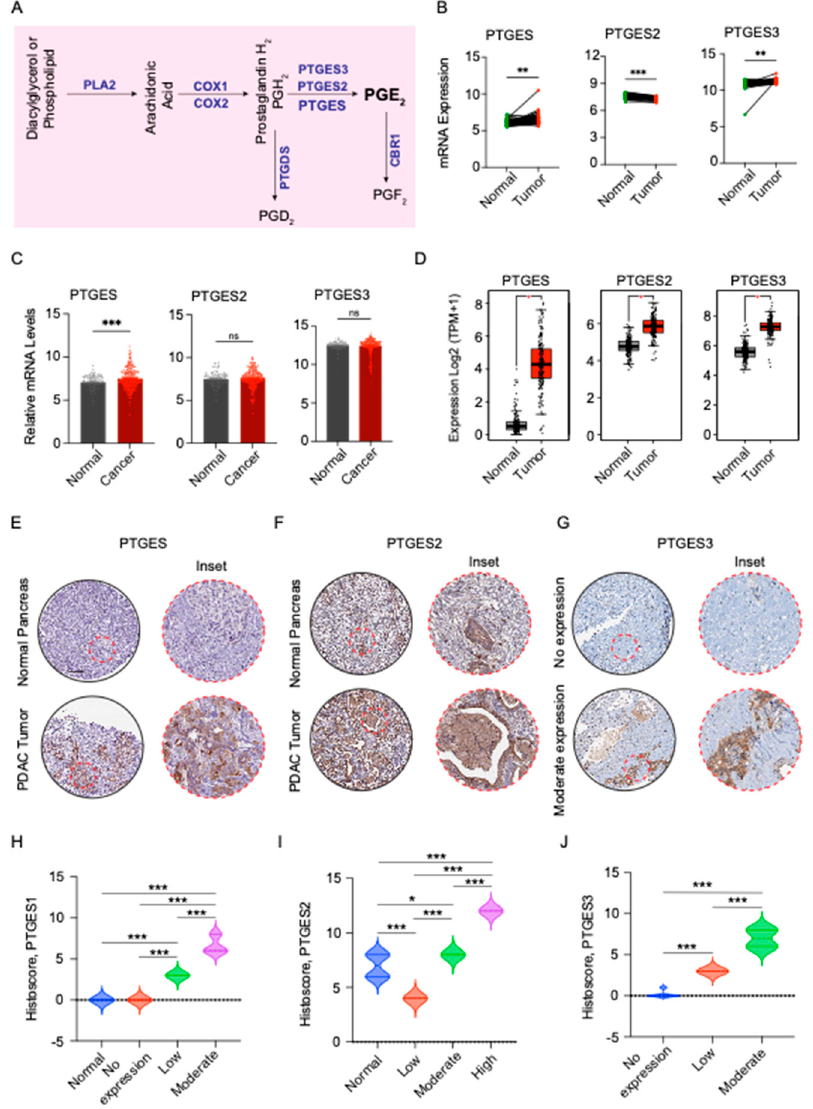
Figure 1. Prostaglandin E synthase expression in pancreatic cancer. ( A ) Schematic illustration of the prostaglandin metabolic pathway. The metabolites are shown in black and the enzymes in blue. ( B ) The relative mRNA expression of the PTGES, PTGES2, and PTGES3 genes in 39 paired normal pancreas and PDAC tumor tissues from the GDS4103 microarray study. ( C ) The relative mRNA expression of the PTGES, PTGES2, and PTGES3 genes in normal pancreas (n = 105) and PDAC tumor tissues (n = 324) from the GENT U133A microarray study. ( D ) The relative mRNA expression of the PTGES, PTGES2, and PTGES3 genes in normal pancreatic tissues from the GTEx study (n = 171) and PDAC tumor tissues (n = 179) from the TCGA PAAD samples. ( E – G ) Representative immunohistochemical images of PTGES ( E ), PTGES2 ( F ), and PTGES3 ( G ) proteins in tissue sections of normal and pancreatic tumor tissues with inset of zoomed images. The scalebar is 200 µm. ( H – J ) The composite histoscores of PTGES ( H ), PTGES2 ( I ), and PTGES3 ( J ) protein expression in normal pancreas tissue and PDAC tumor tissues from the Protein Atlas Database. The p -values are denoted by * < 0.05, ** < 0.01, and *** < 0.001, ns not significant.